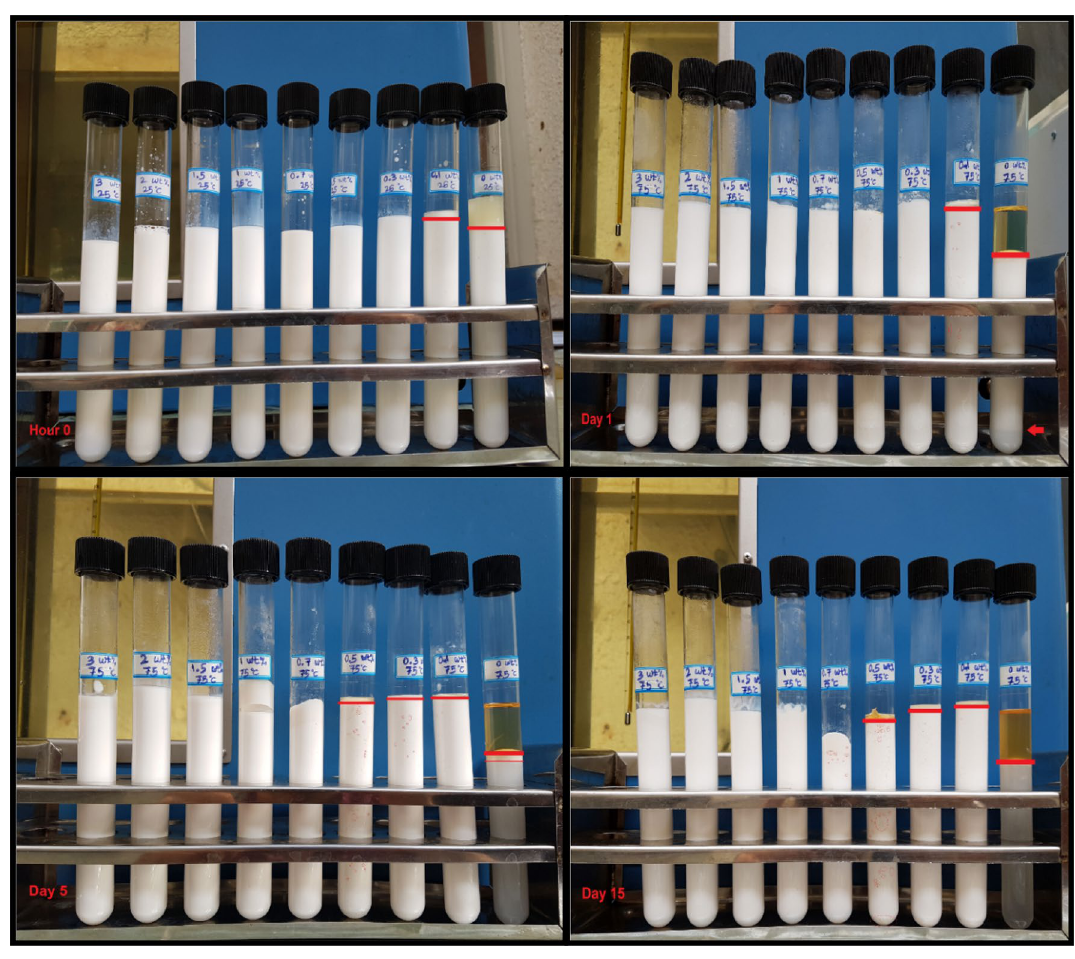
Fig. 13 Photographs of emulsions in different days formed with various SDS concentrations